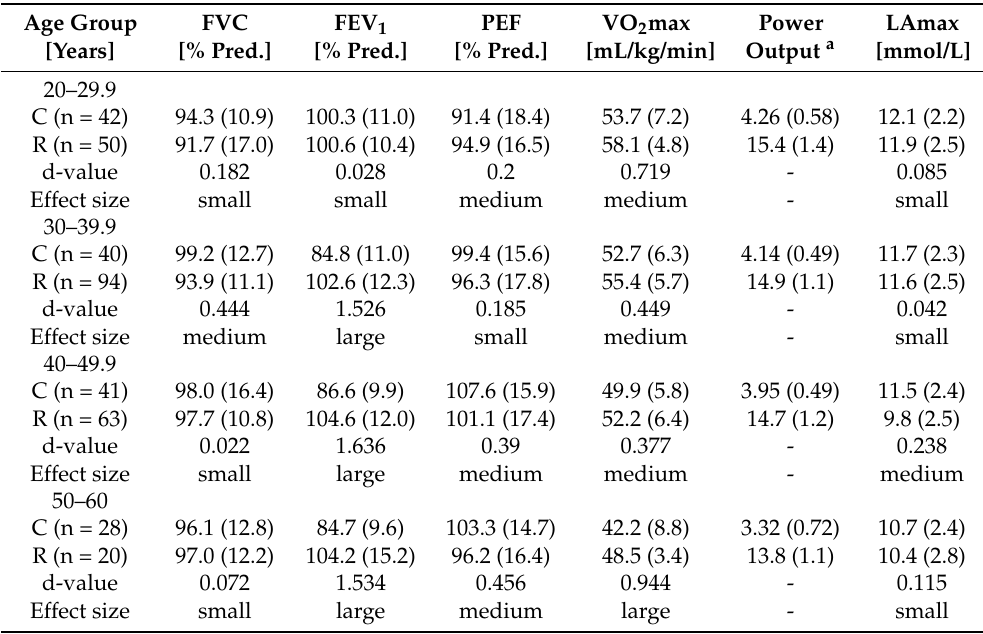
Table 2. Pulmonary function (FVC forced vital capacity; FEV 1 forced expiratory volume in 1 s; PEF peak expiratory flow) and performance characteristics in male recreational cyclists (C) and runners